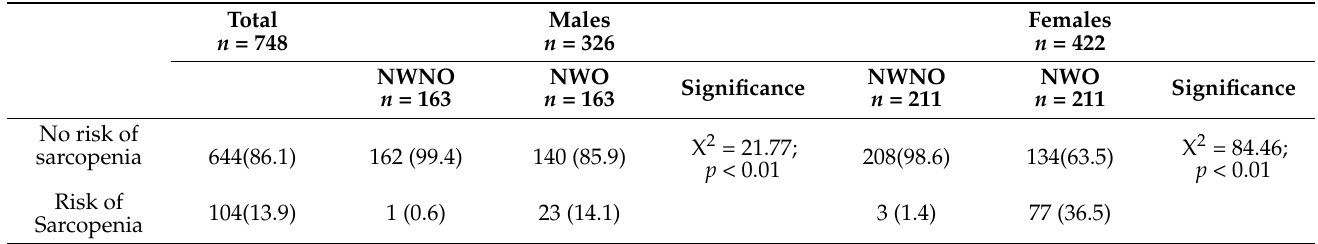
Table 2. The risk of sarcopenia in NWNO and NWO across gender ¥ ( n = 743). Total n = 748